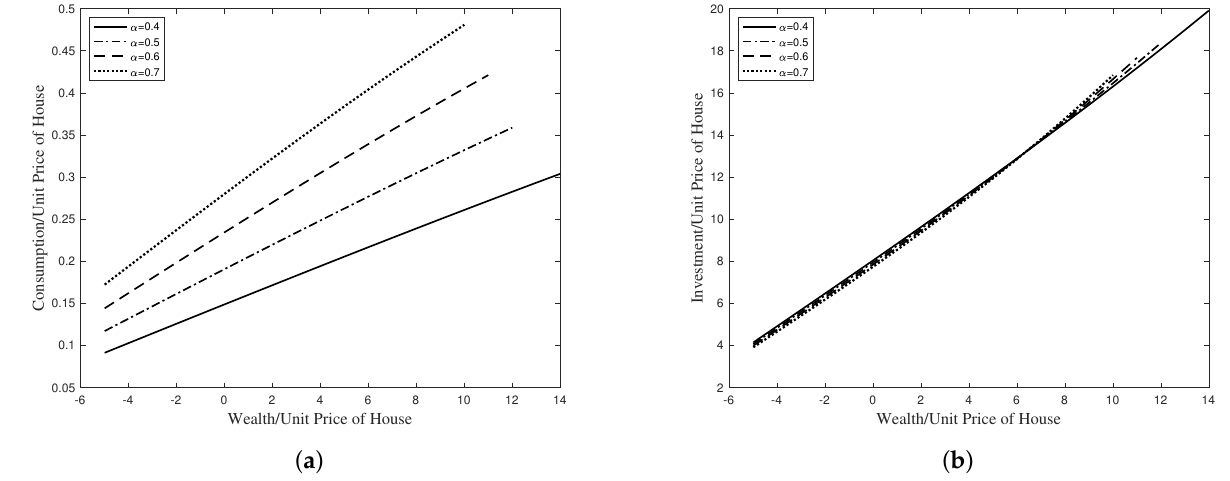
Figure 8. Optimal consumption and investment policies with changes in elasticity of substitution between consumption and housing. ( a ) Consumption. ( b )